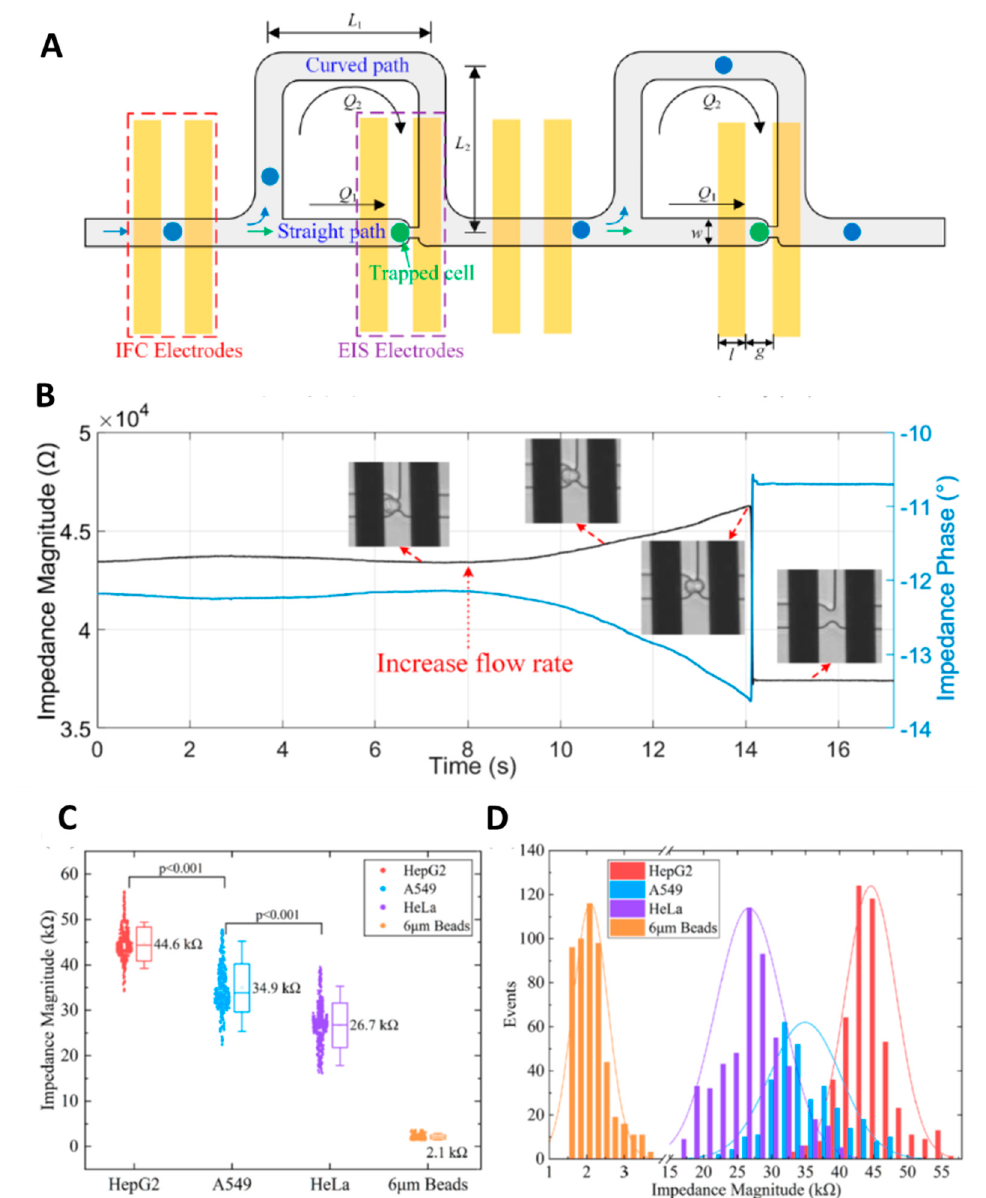
Figure 10. ( A ) Schematic diagram of the microchip structure depicting the cells passing/trapping for impedance flow cytometry (IFC)/ electrochemical impedance spectroscopy (EIS)sensing. Cells would pass through the IFC channel and then be trapped in the EIS site. ( B ) The dynamic response of EIS-based impedance magnitude and phase when the flow rate was kept as 10 nL/min for a while and then increased to 10 µL/min ( f = 1 MHz). ( C ) The average impedance magnitudes of HepG2, A549, HeLa cells and 6 µm beads, showing significant difference ( p < 0.001). ( D ) The impedance magnitudes of cells and beads exhibit Gaussian distribution in population. Reprinted from Feng et al. [53] with permission from American Chemical Society.